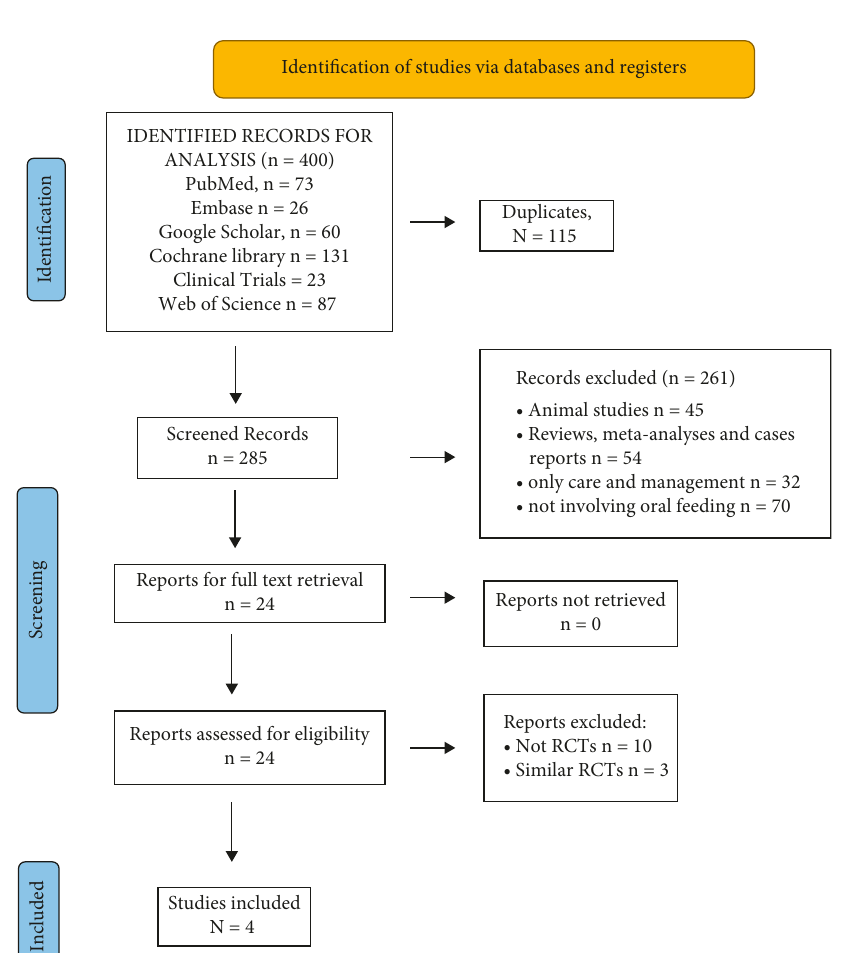
Figure 2: Flowchart of the literature search process and results.